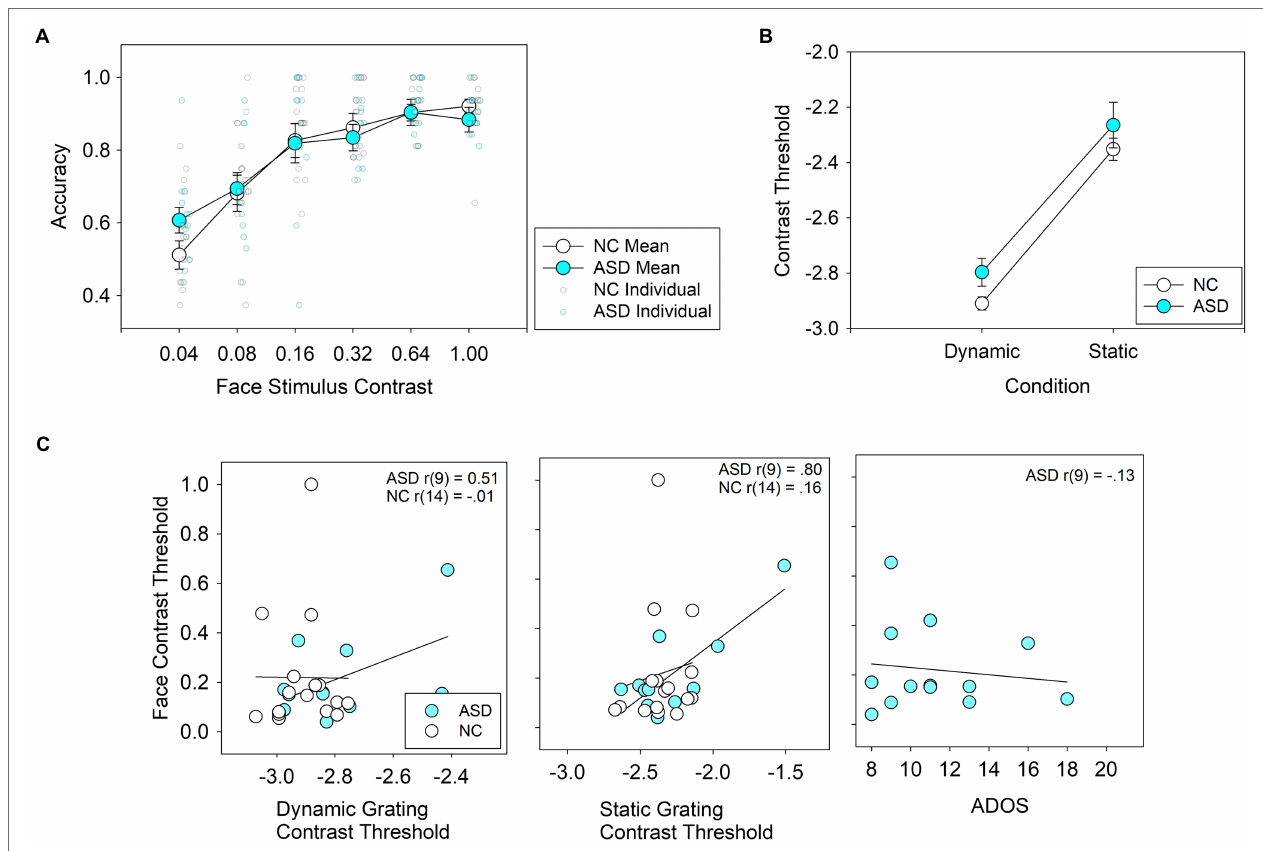
FIGURE 2 | (A) Average accuracy for face detection in individuals with autism spectrum disorder (ASD) and neurotypical controls (NC) across 6 contrast levels. Group means are represented by large, bold circles, and individual scores are represented by semi-translucent, small circles. (B) Average thresholds for contrast detection using grating stimuli. (C) Correlations between face detection thresholds and dynamic contrast detection thresholds (left panel), static contrast detection thresholds (middle panel) and ADOS scores (right panel).For the left and middle panels, the logarithm of grating contrast detection thresholds is